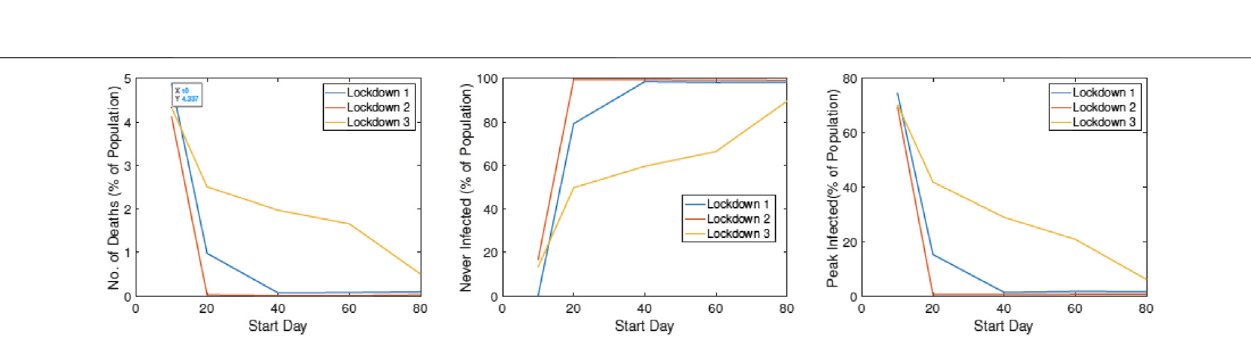
FIGURE 15 | Statistical summaries of infection variables obtained using 30 runs of ALPS, plotted against T 1 , the reopening day. In all three types of lockdowns, a delay in reopening after a lockdown helps control the number of infections and deaths.